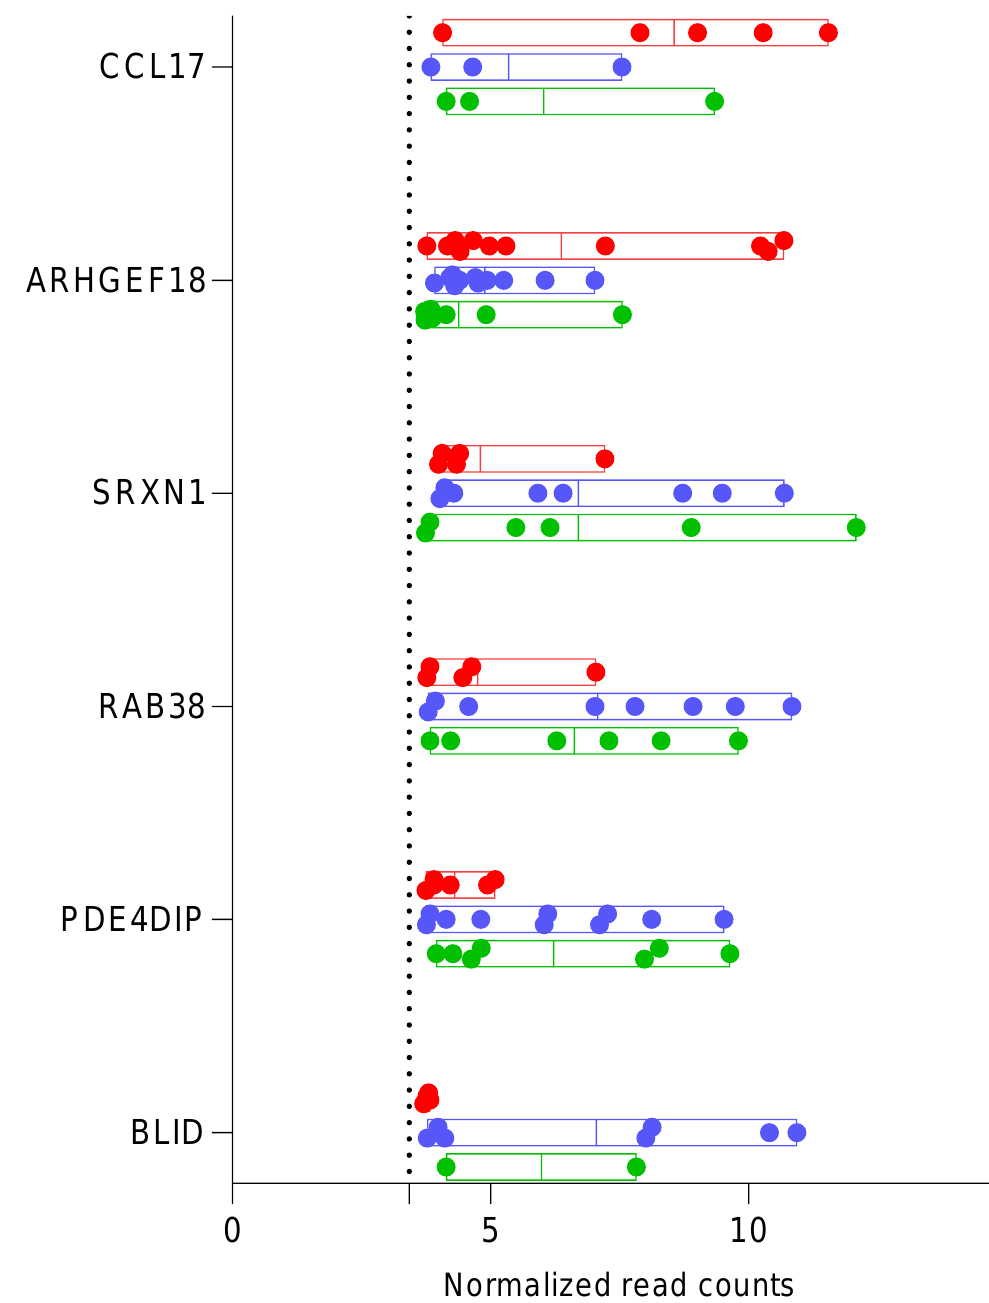
Figure 3. Distribution of read counts across individual samples for cfRNA of replicated protein- coding genes. Each dot represents cfRNA read counts for a given gene within individual samples. Red—genes in cases; blue—smokers with benign PN; green—healthy non-smokers. The dotted line represents the threshold for detecting read counts that was set at 3.4298.